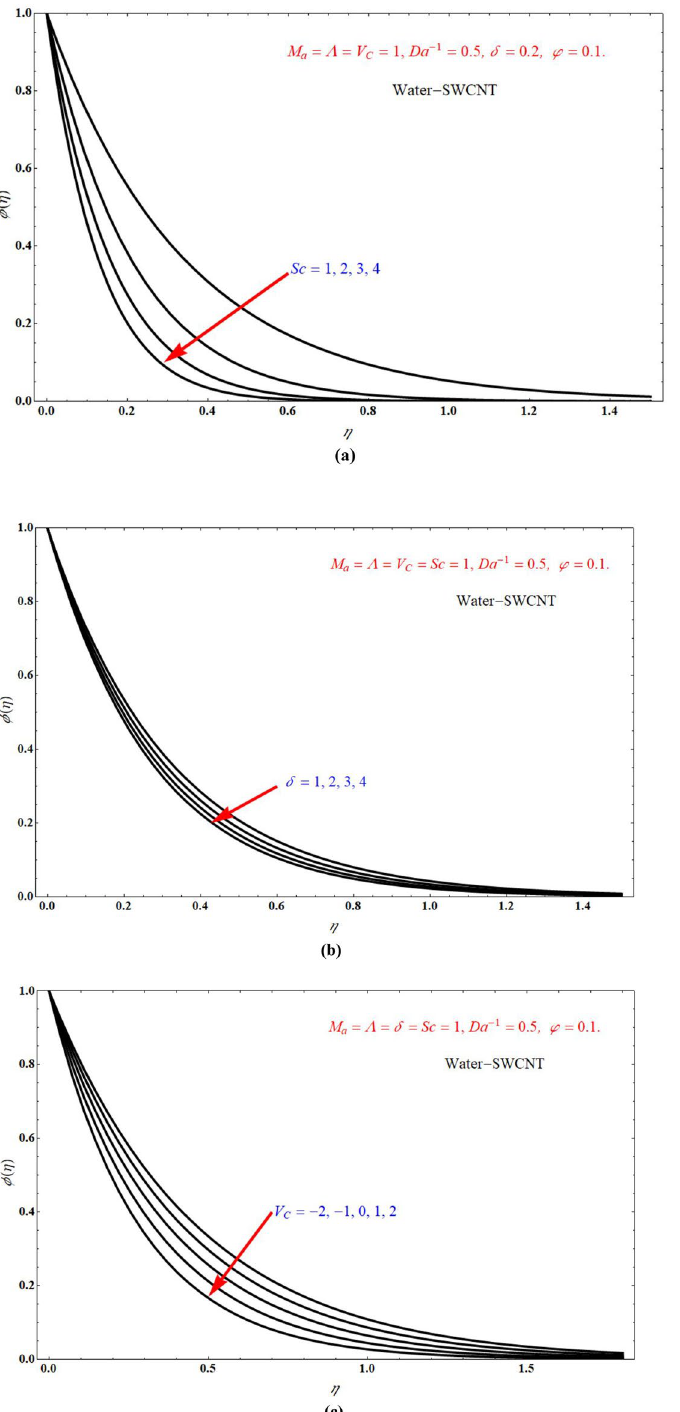
Figure 12. The plots of φ(η) verses η for different choices of ( a ) Sc ( b ) δ and ( c ) V C